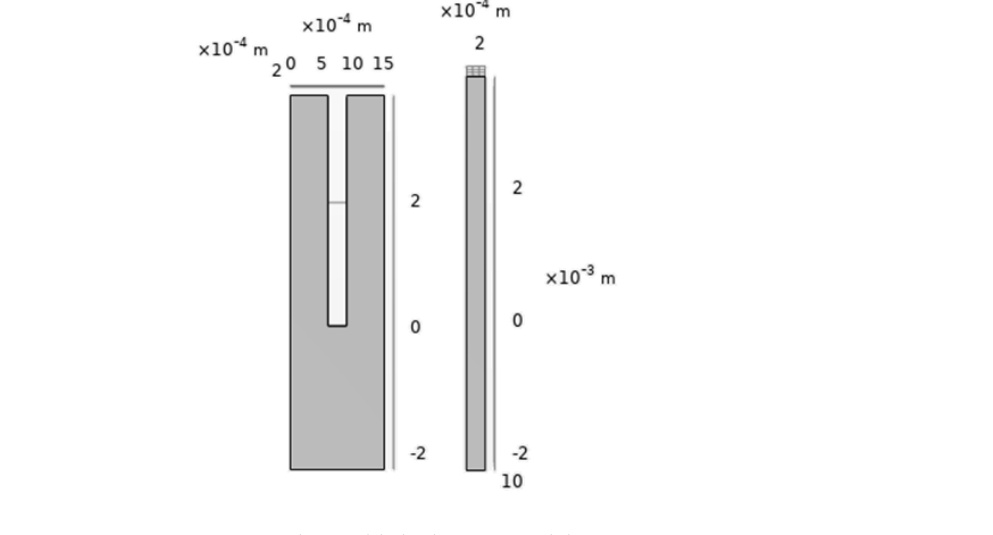
Figure 3. Structural model diagram of the QCTF.